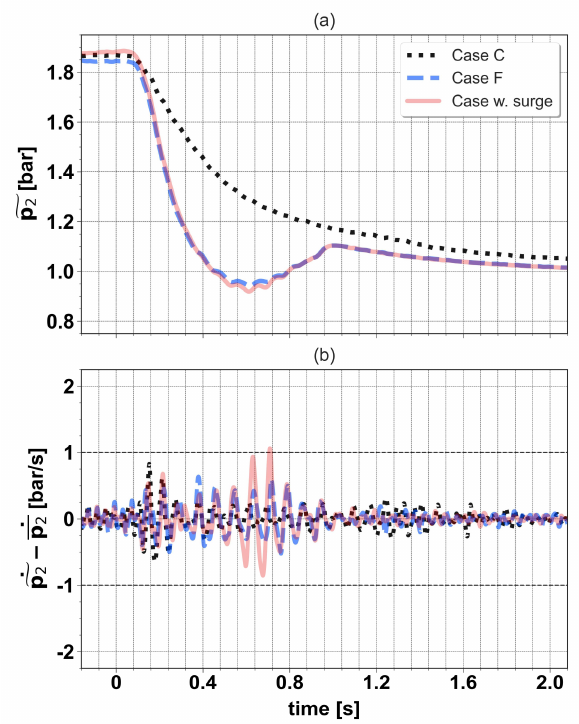
Figure A2. Time evolution of compressor outlet pressure ( a ) and its time derivative ( b ) for Case C, Case F, and a case with surge, in relation to the re-optimization of the throttle actuation for the p 1 level equal to 0.65